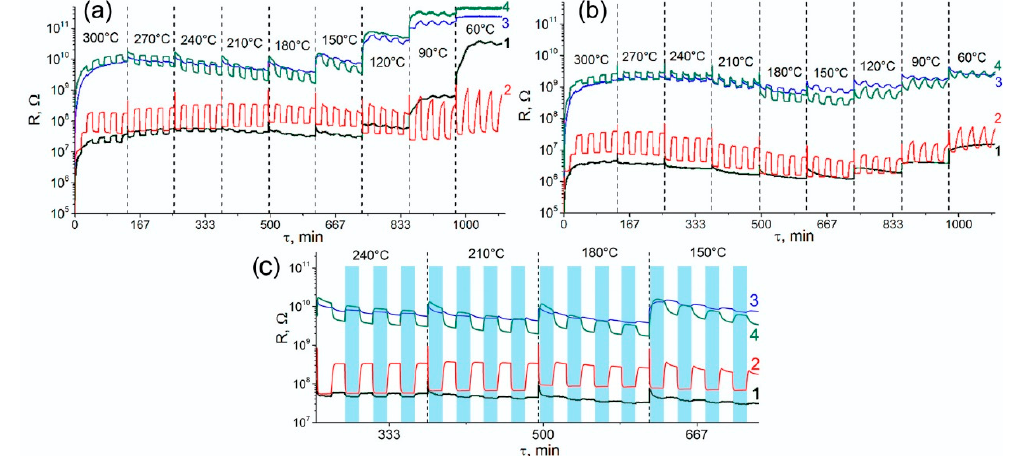
Figure 1. Resistance of the samples in the temperature range 60–300 °C under the periodic change of the gas phase composition at relative humidity ( a ) Relative Humidity (RH) = 0% and ( b ) RH = 20%. ( c ) An enlarged image of the resistance variation of the samples when measured in dry air (RH = 0%). (1) SnO 2 , (2) SnO 2 /Pd, (3) SnO 2 /Pt, (4) SnO 2 /PtPd. Pale blue areas correspond to exposure in CO.